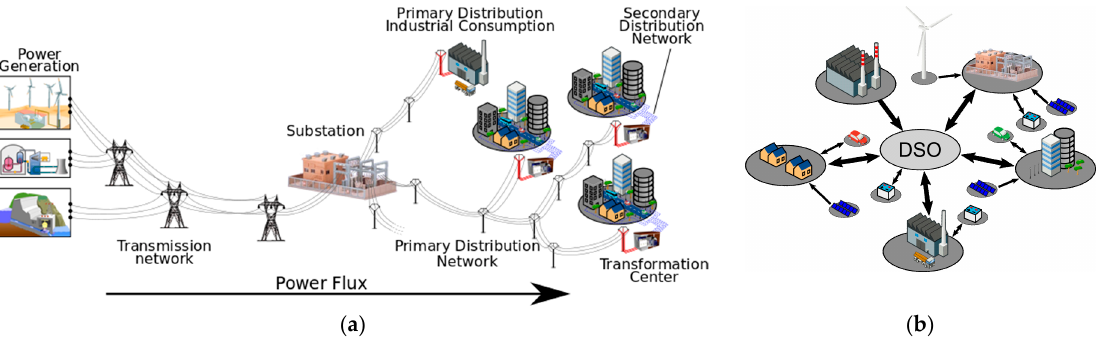
Figure 5. ( a ) Traditional distribution line topology; and ( b ) Smart grid topology.